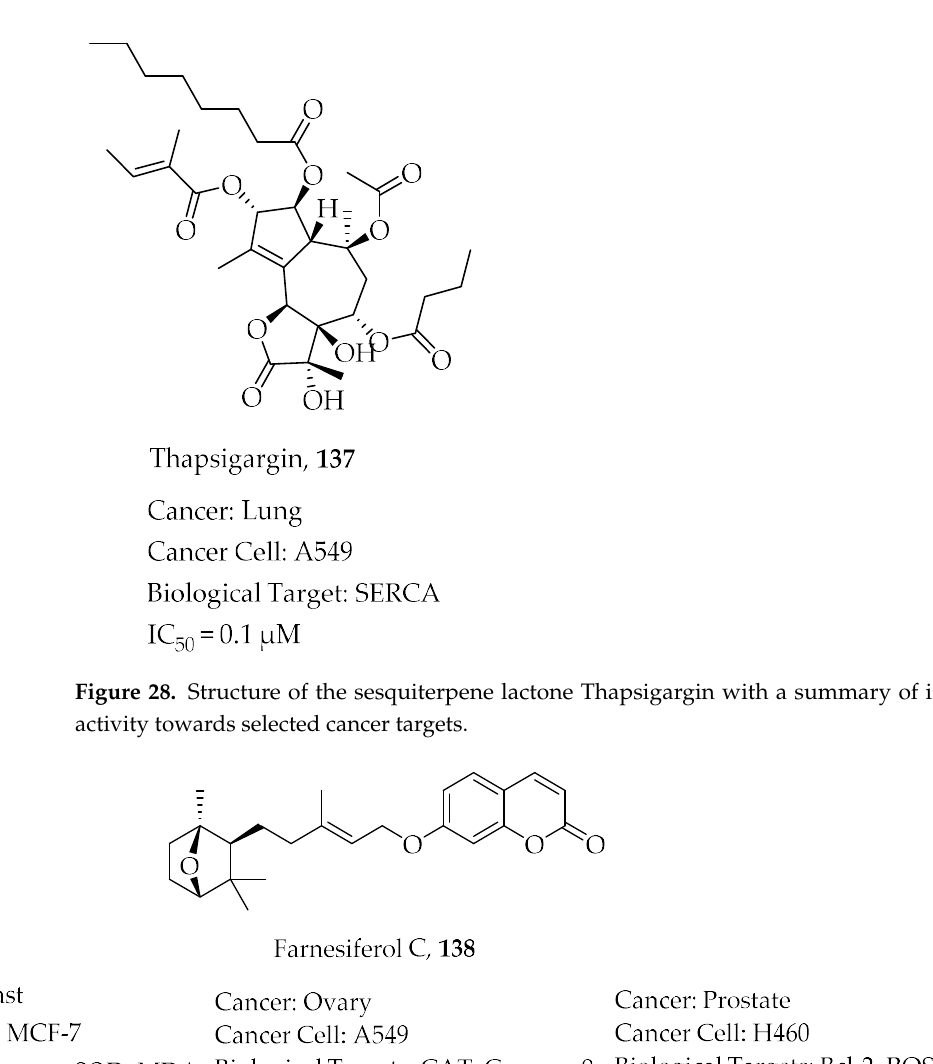
Figure 29. Structure a sesquiterpene coumarin Farnesiferol C with the summary of its biological activity towards selected cancer targets.